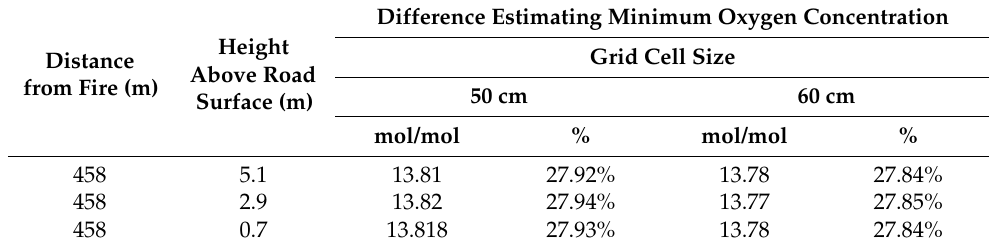
Figure 4. Oxygen concentration, 458 m downstream, 0.7 m above the road surface. Table 4. Comparison between minimum simulated and experimental values of oxygen concentration.